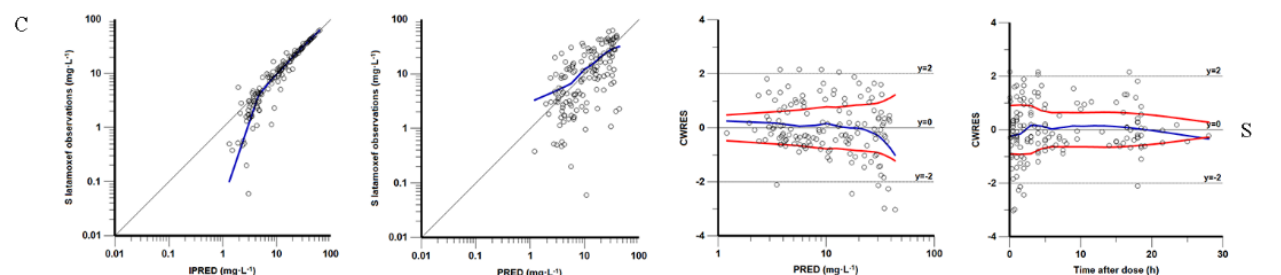
Figure 1. Goodness-of-fit plots of the final established population pharmacokinetic models: ( A ) R latamoxef, ( B ) R + S latamoxef, and ( C ) S latamoxef. From left to right. These plots are observed concentration versus individual-predicted concentration (IPRED), observed concentration versus population-predicted concentration (PRED), conditional weighted residuals (CWRES) versus PRED, and CWRES versus time after dose, respectively.